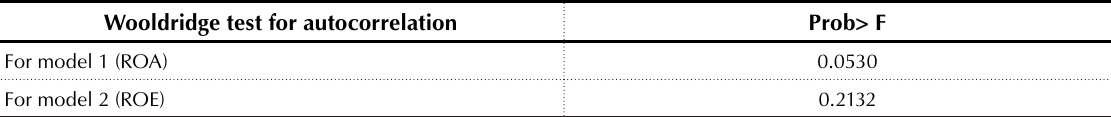
Table 5. Wooldridge test for autocorrelation Wooldridge test for autocorrelation